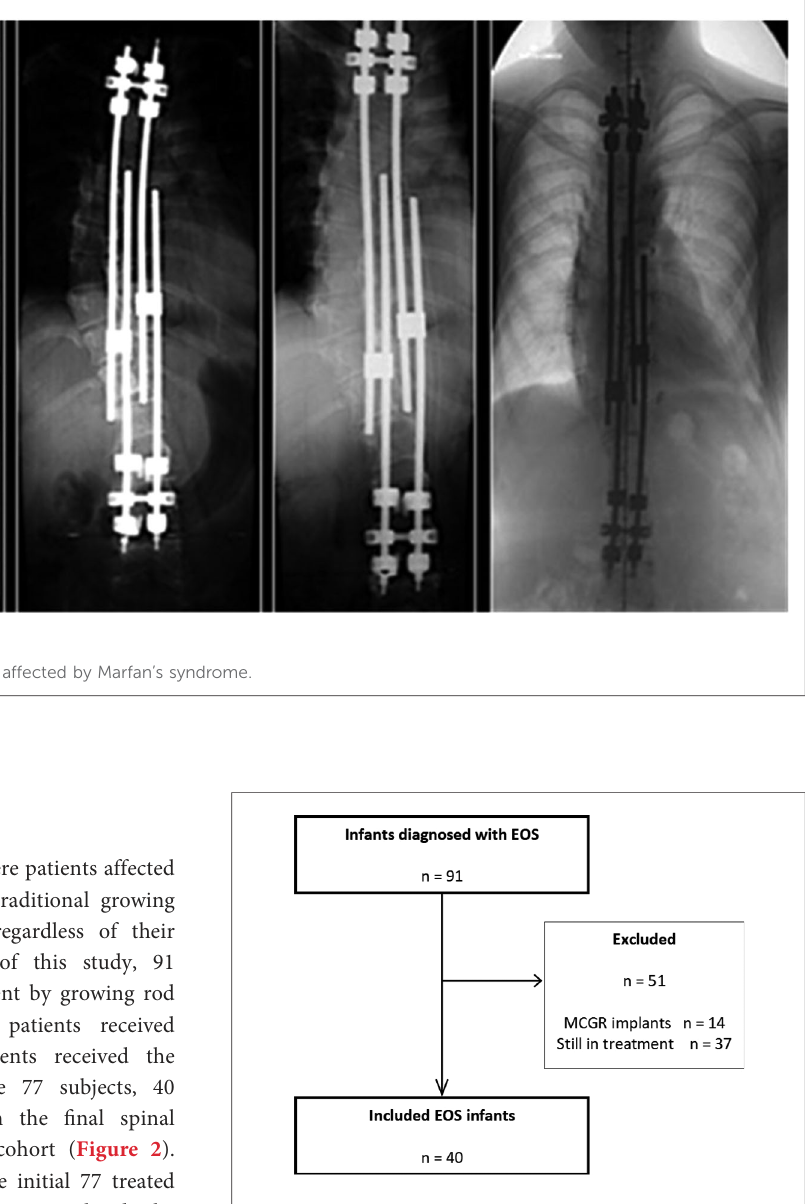
FIGURE 2 Flowchart of selected infants with EOS diagnosis treated with growing rods implant systems. EOS, early onset scoliosis.